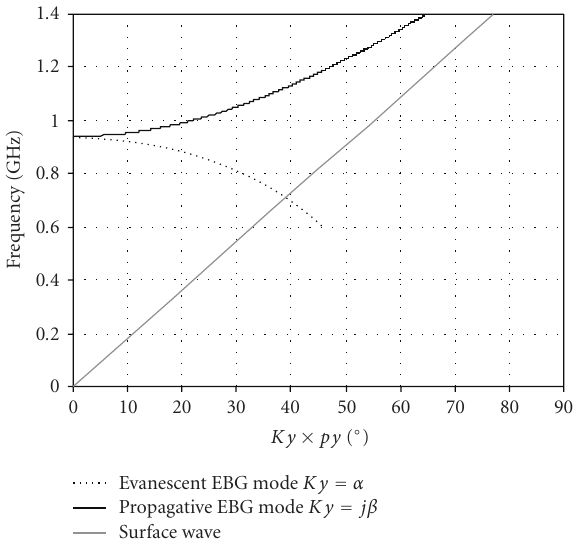
Figure 9: Dispersion diagram of the low profile EBG resonator.